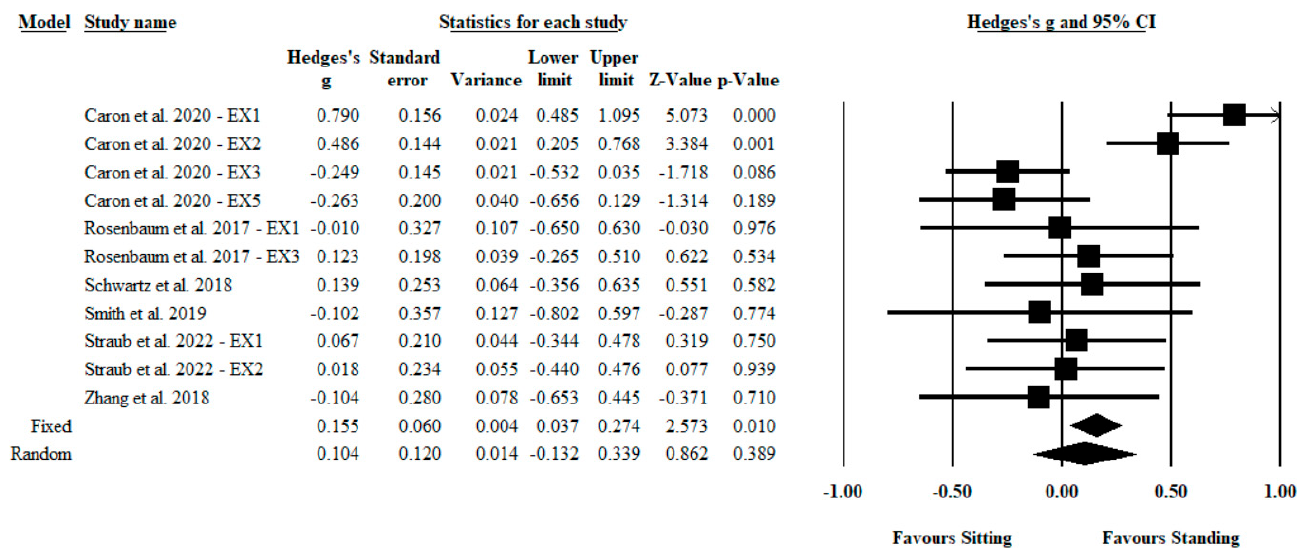
Figure 3. Forest plot of the Hedges’ g differences between sitting and standing conditions for congruent stimuli.